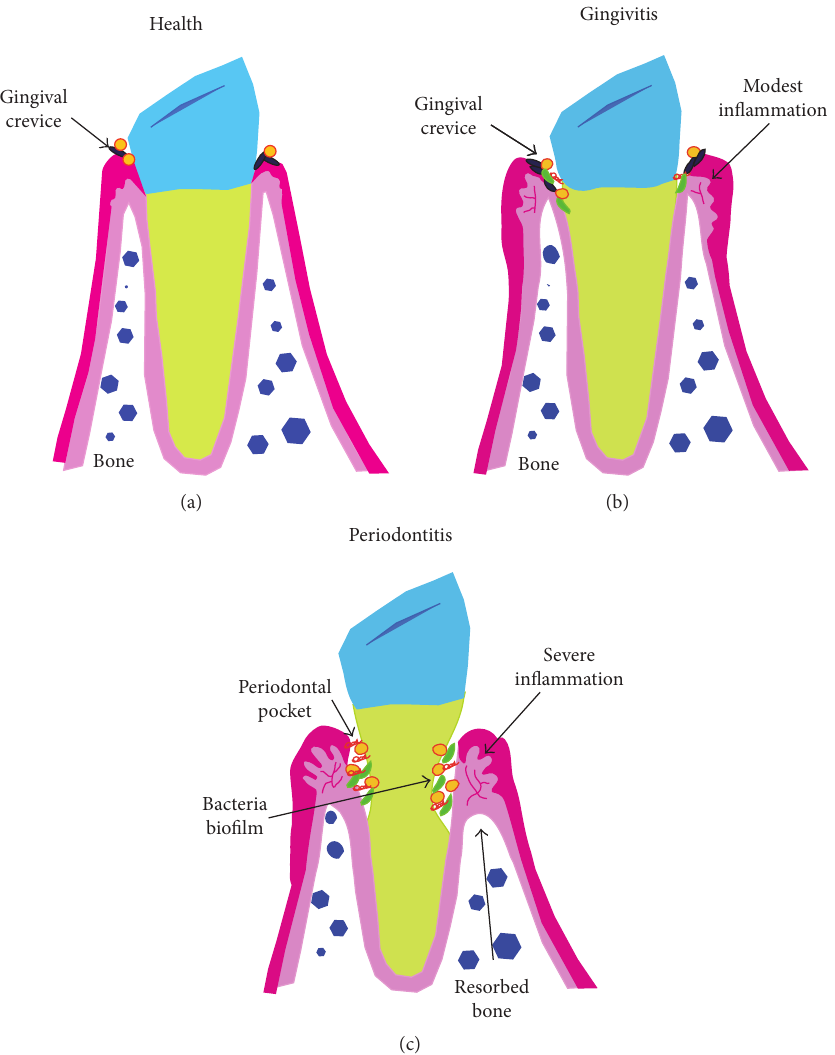
Figure 1: The evolution from a healthy periodontium to periodontitis . (a) Healthy tooth with no inflammation and a small gingival crevice (space between the tooth surface and the free gingiva). (b) A change in oral microbiota leads to increased bacteria biofilm deposition in the gingival crevice and produces moderate inflammation (gingivitis). (c) In severe cases, a chronic inflammatory state known as periodontitis is established, resulting in the formation of periodontal pockets (pathologically deepened gingival crevices) with extensive tissue destruction including bone